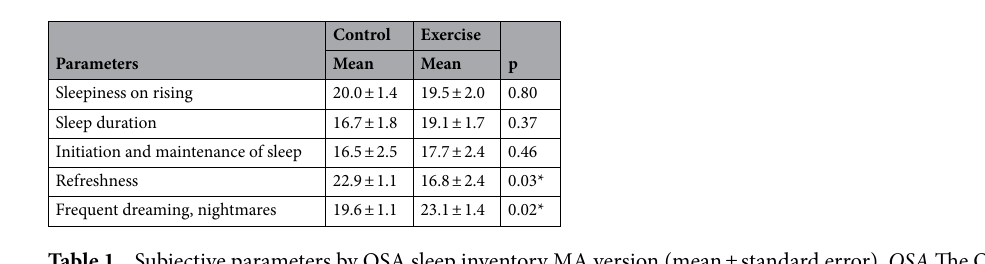
Table 1. Subjective parameters by OSA sleep inventory MA version (mean ± standard error). OSA The Oguri Shirakawa and Azumi standard rating scale, MA middle age and aged version. * p < 0.05.